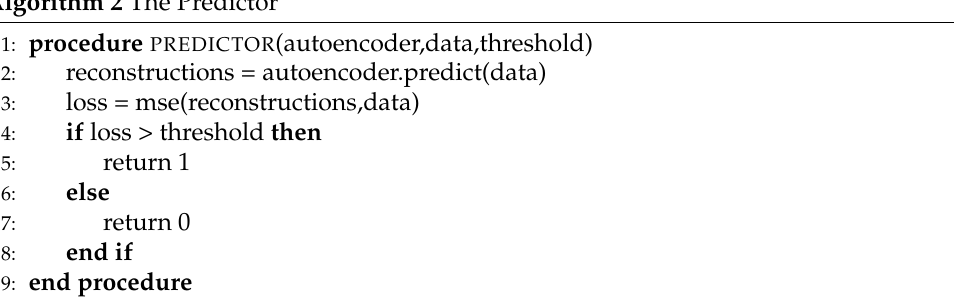
Algorithm 2 The